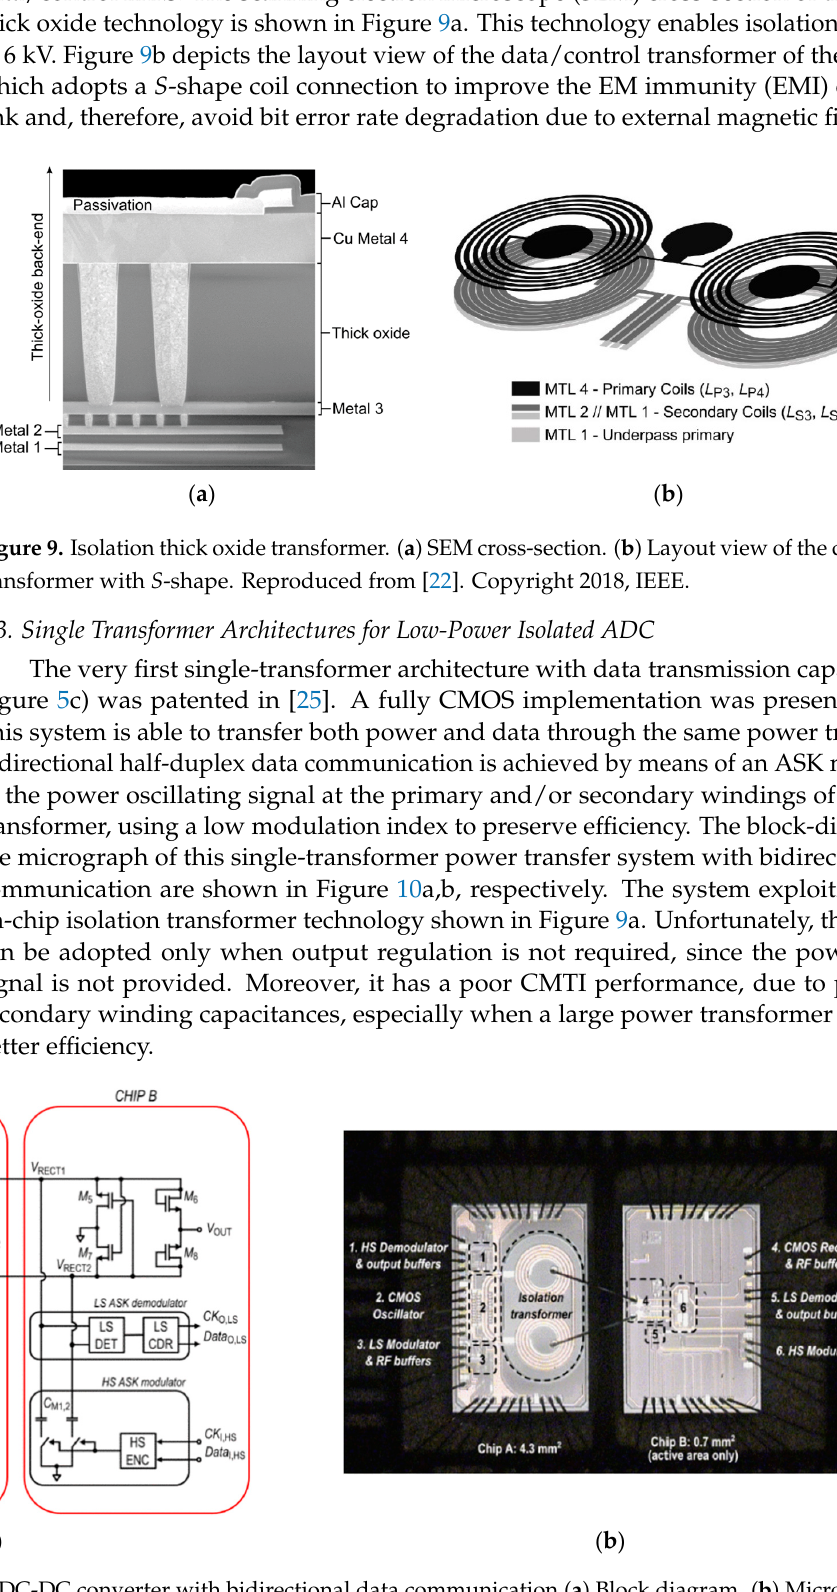
Figure 8. DC–DC converter with bidirectional data communication ( a ) Block diagram. ( b ) Micrograph. Reproduced from